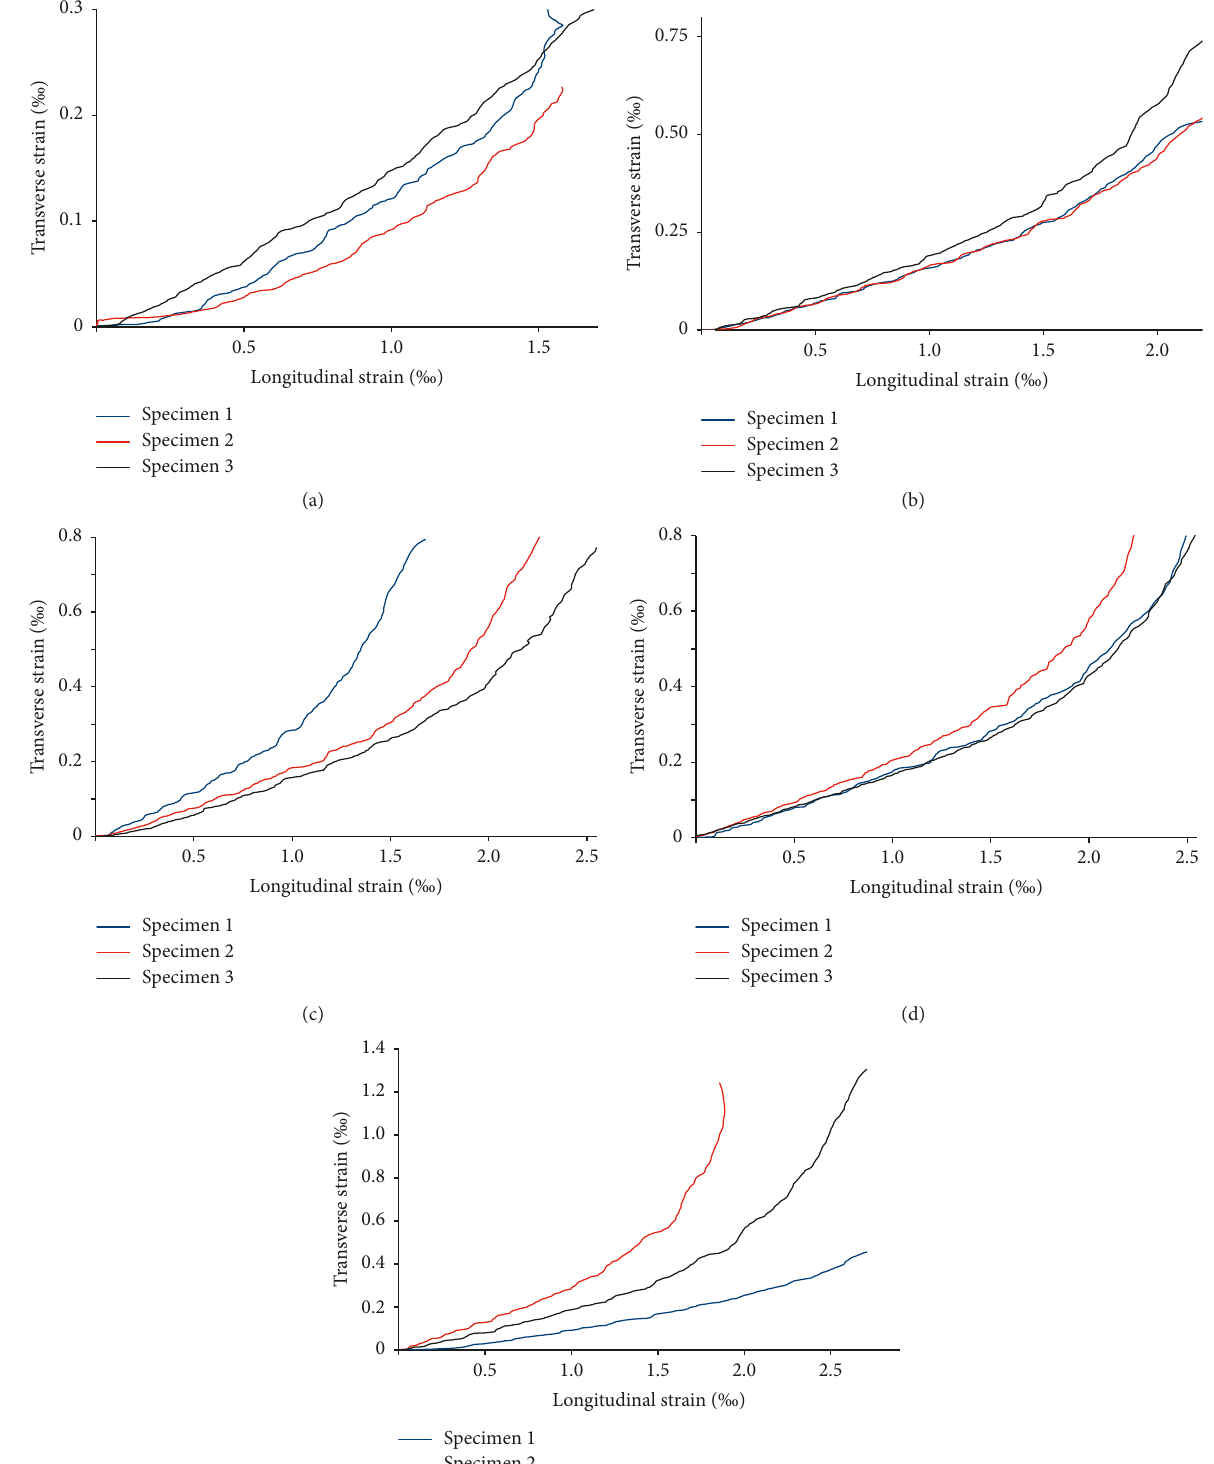
Figure 6: Dependence of transverse strain on longitudinal one for (a) FWR m 3 ; (e) FWR